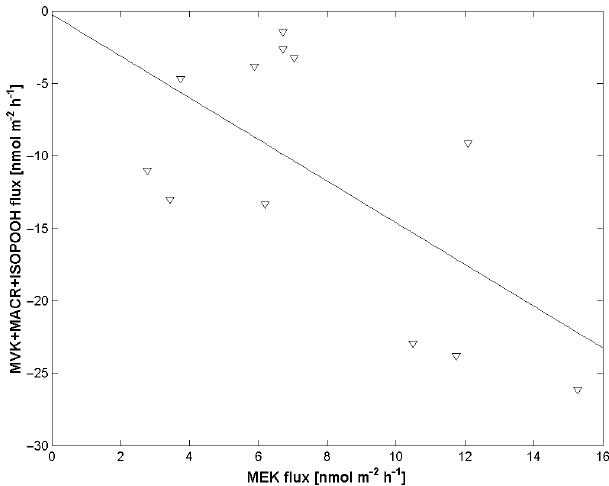
Figure 4. Scatter plot of branch-level MEK fluxes versus MACR + MVK + ISOPOOH fluxes during darkness in the period of 21–25 August. Linear fit parameters are the following: R 2 = 0 . 401; y = − 1 . 44 x − 0 .